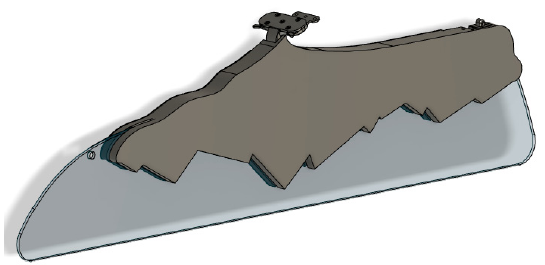
Figure 9. Redesigned class-divider part.